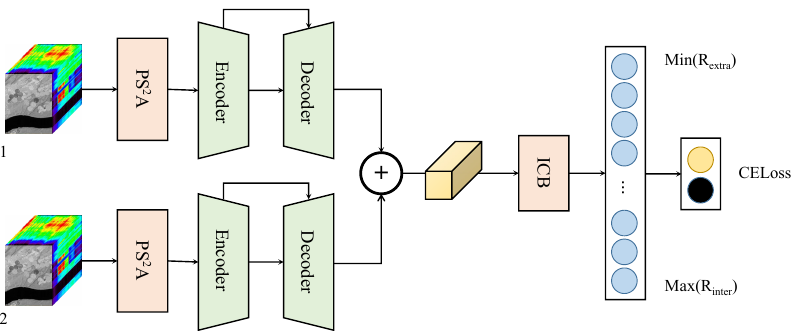
Figure 1. The overall architecture of the proposed TFR-PS 2 ANet. TFR-PS 2 ANet consists of four components: PS 2 A module, two-branch encoder–decoder architecture, ICB module, and feature redistribution loss function.